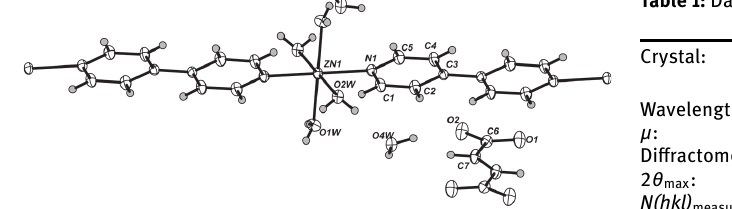
Table 1: Data collection and handling.